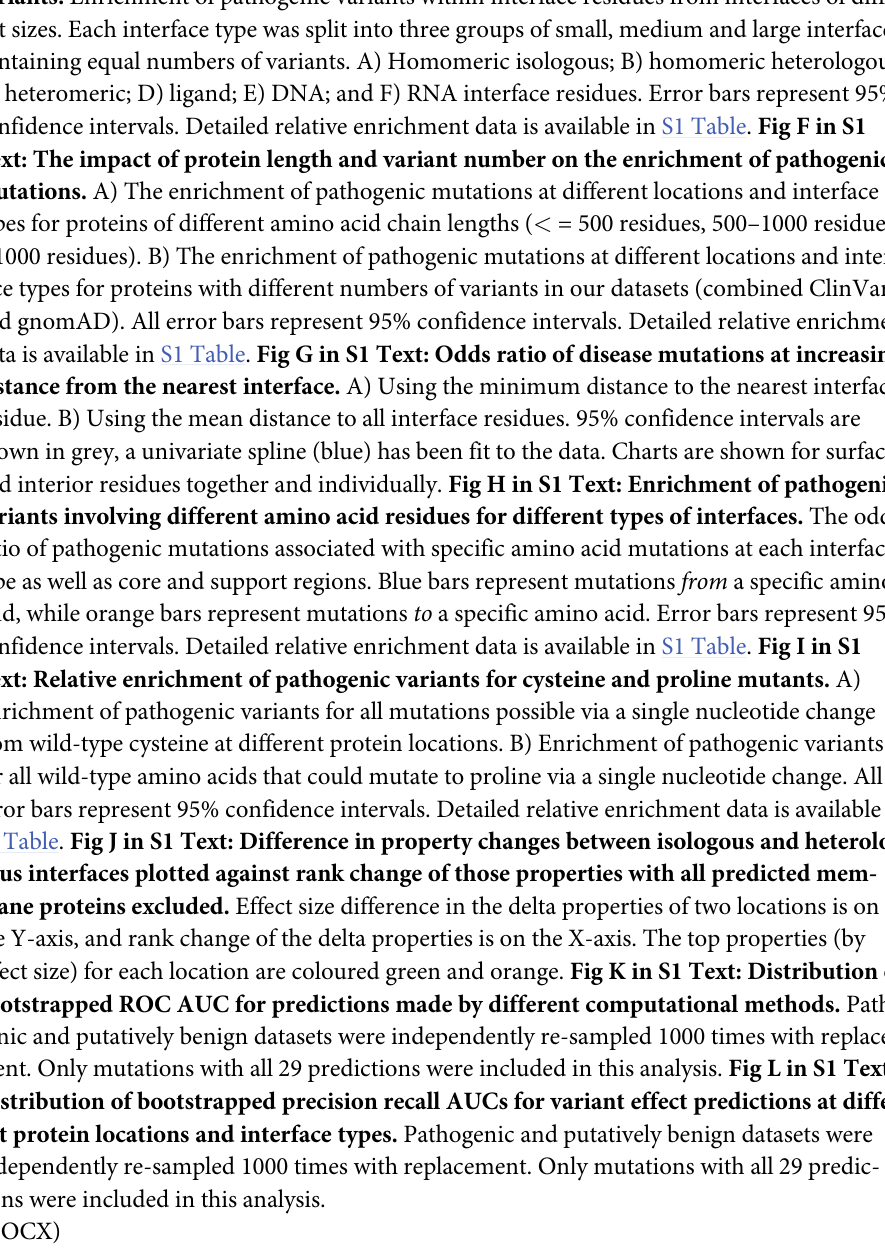
S1 Table. Sample numbers, odds ratios, confidence intervals and p-values for all enrich- ment analyses.